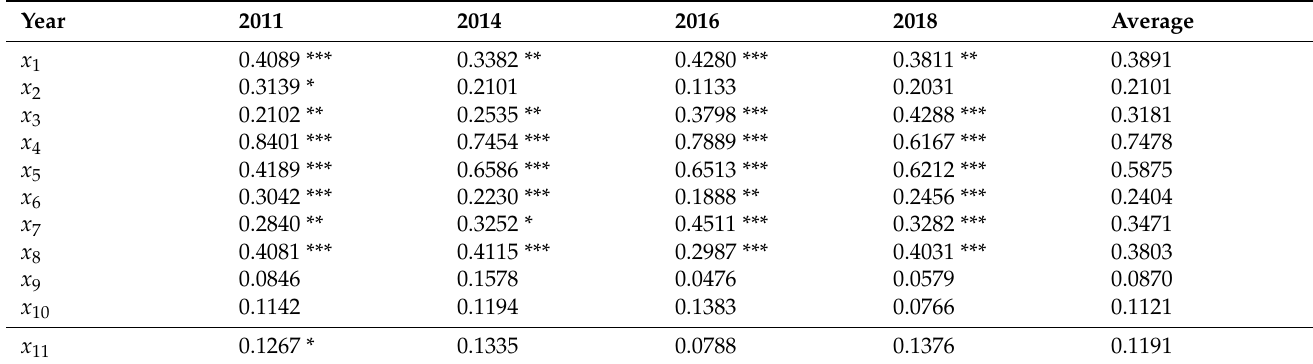
Table 4. Detection results of factors affecting urban resilience in the